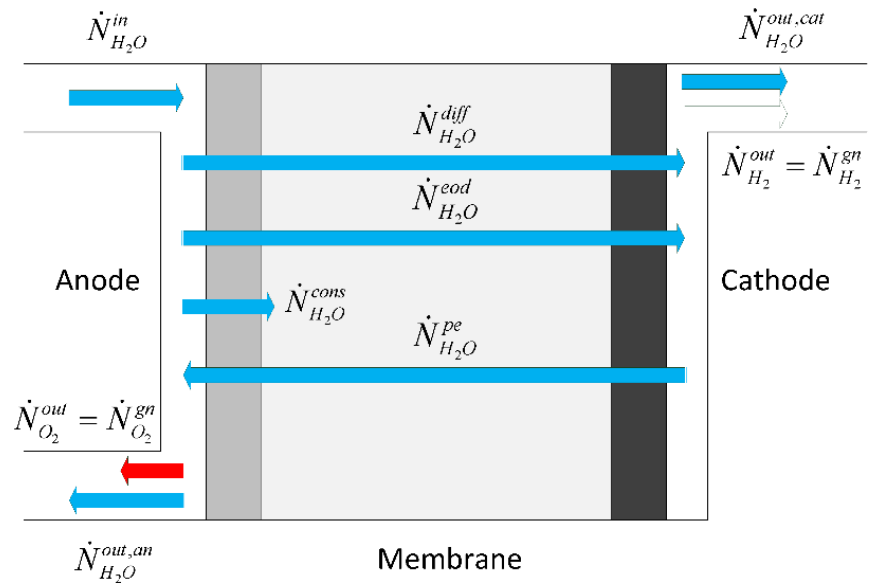
Figure 2. Molar balance in the PEM electrolyzer assembly (adapted from [8]).